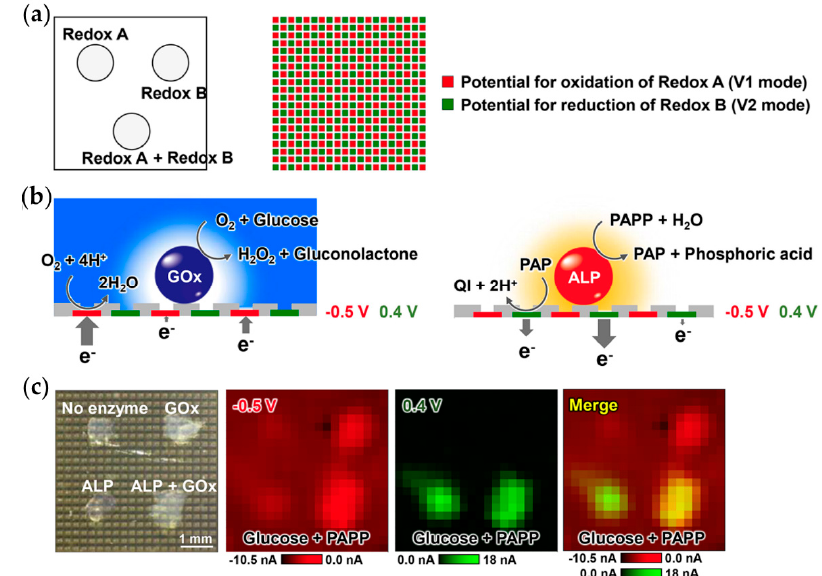
Figure 9. Principles and example images using electrochemicolor imaging. ( a ) Schematic of a sample over a microelectrode array that has individual alternate electrodes set at a potential to oxidize redox species A (red) and reduce redox species B (green). ( b ) Schematics for the detection mechanism of GOx activity (left) and ALP activity (right). ( c ) Optical microscope image (left) and electrochemical current images (right three panels) of four membranes on the microelectrode array (MEA) device with glucose and PAPP. (Adapted with permission from Reference [136] (http://pubs.acs.org/doi/10.1021/ acs.analchem.7b03042). Further permissions related to the material excerpted should be directed to the